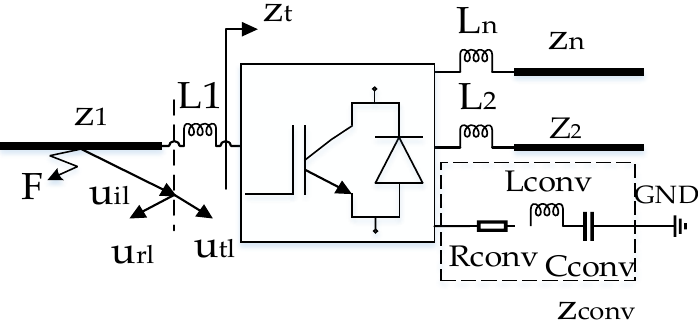
Figure 16. Multi-terminal high-voltage direct current (MT – HVdc) converter station under fault condition.